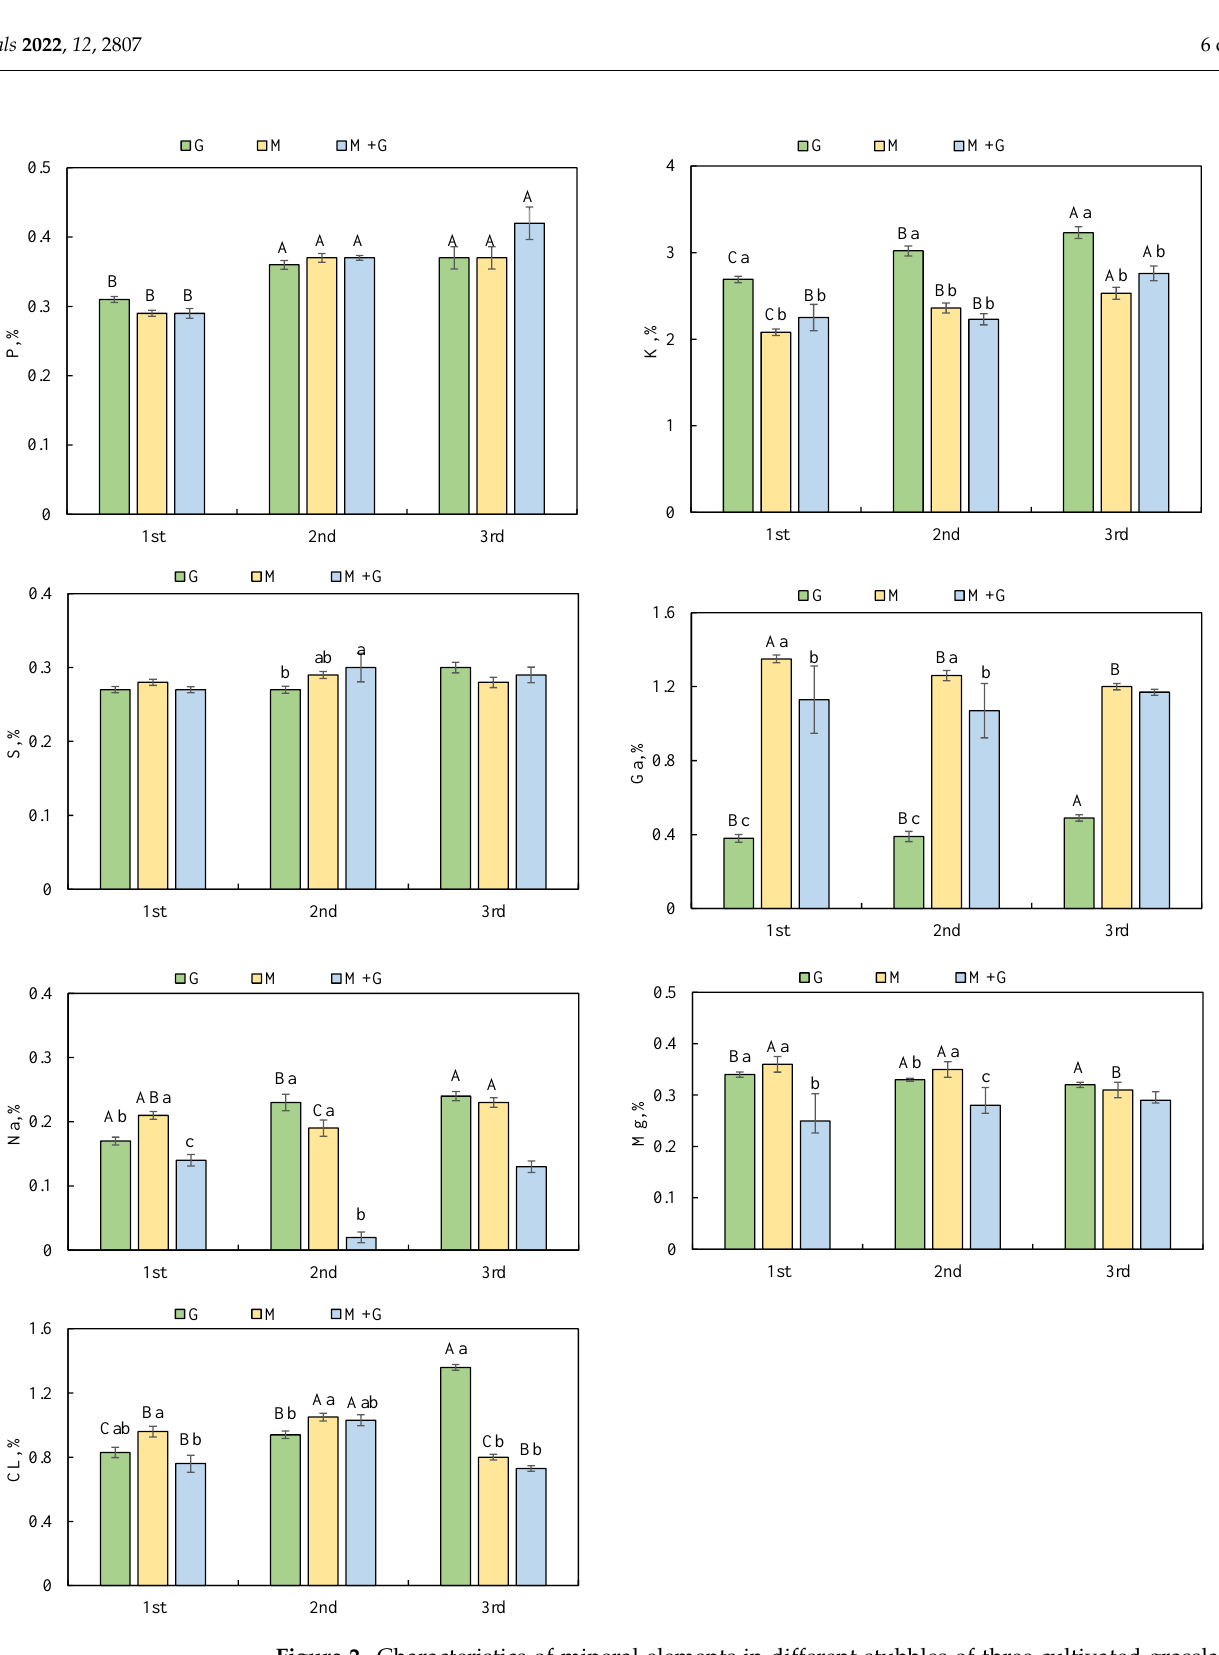
Figure 2. Characteristics of mineral elements in different stubbles of three cultivated grasslands. Phosphorus (P), Potassium (K), Sulfur (S), Calcium (Ca), Sodium (Na), Magnesium (Mg) and Chlorine (CL). Different capital letters indicate the differences among the same forage in different stubbles, and lowercase letters indicate the differences among different forages in the same stubble.